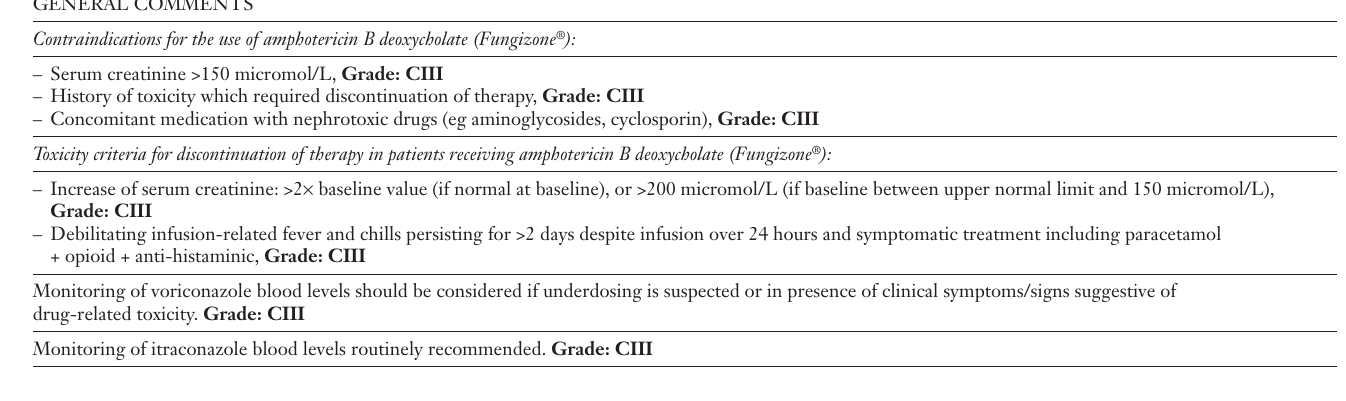
Daily hospital acquisition costs*